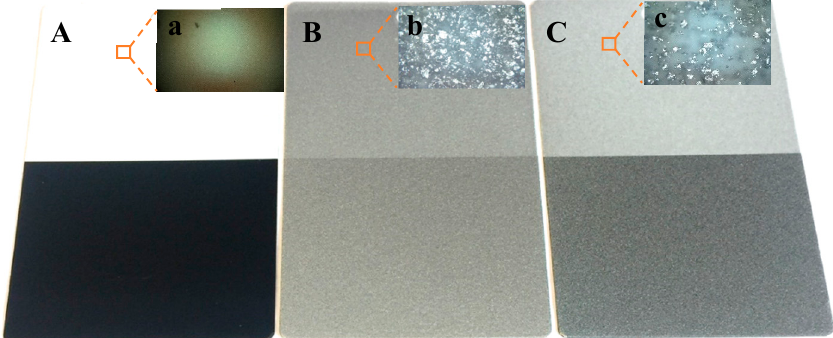
Figure 10. Surface comparisons between final films from various samples. ( A ) Clear coat, ( B ) Non-bonded sample, ( C ) Bonded sample.